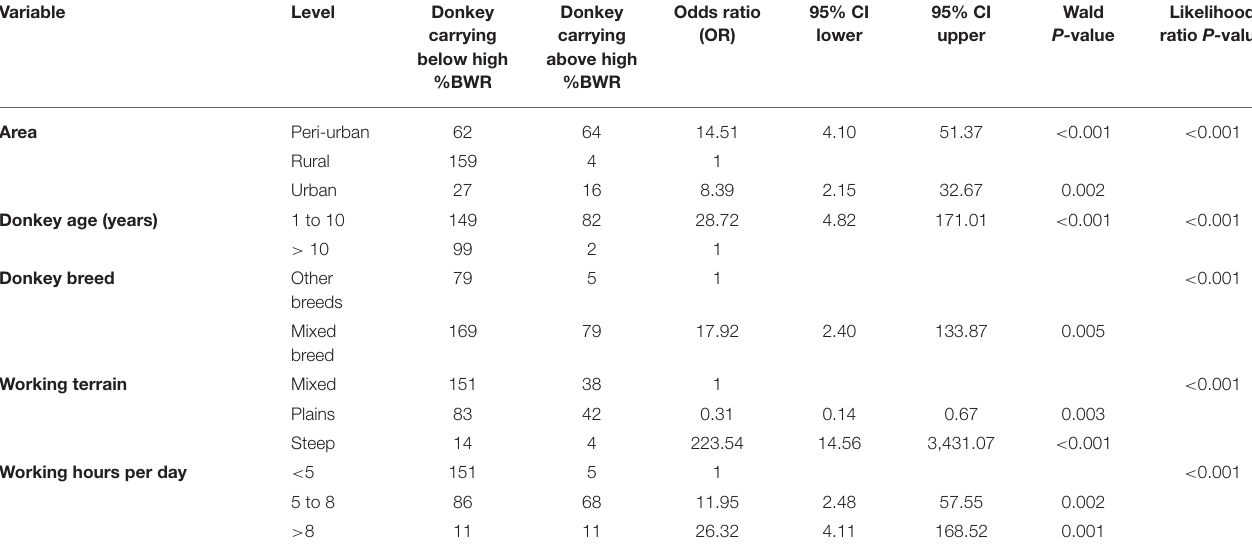
TABLE 5 | Multivariable regression model for the high percent body weight ratio (%BWR) of load carrying donkeys.